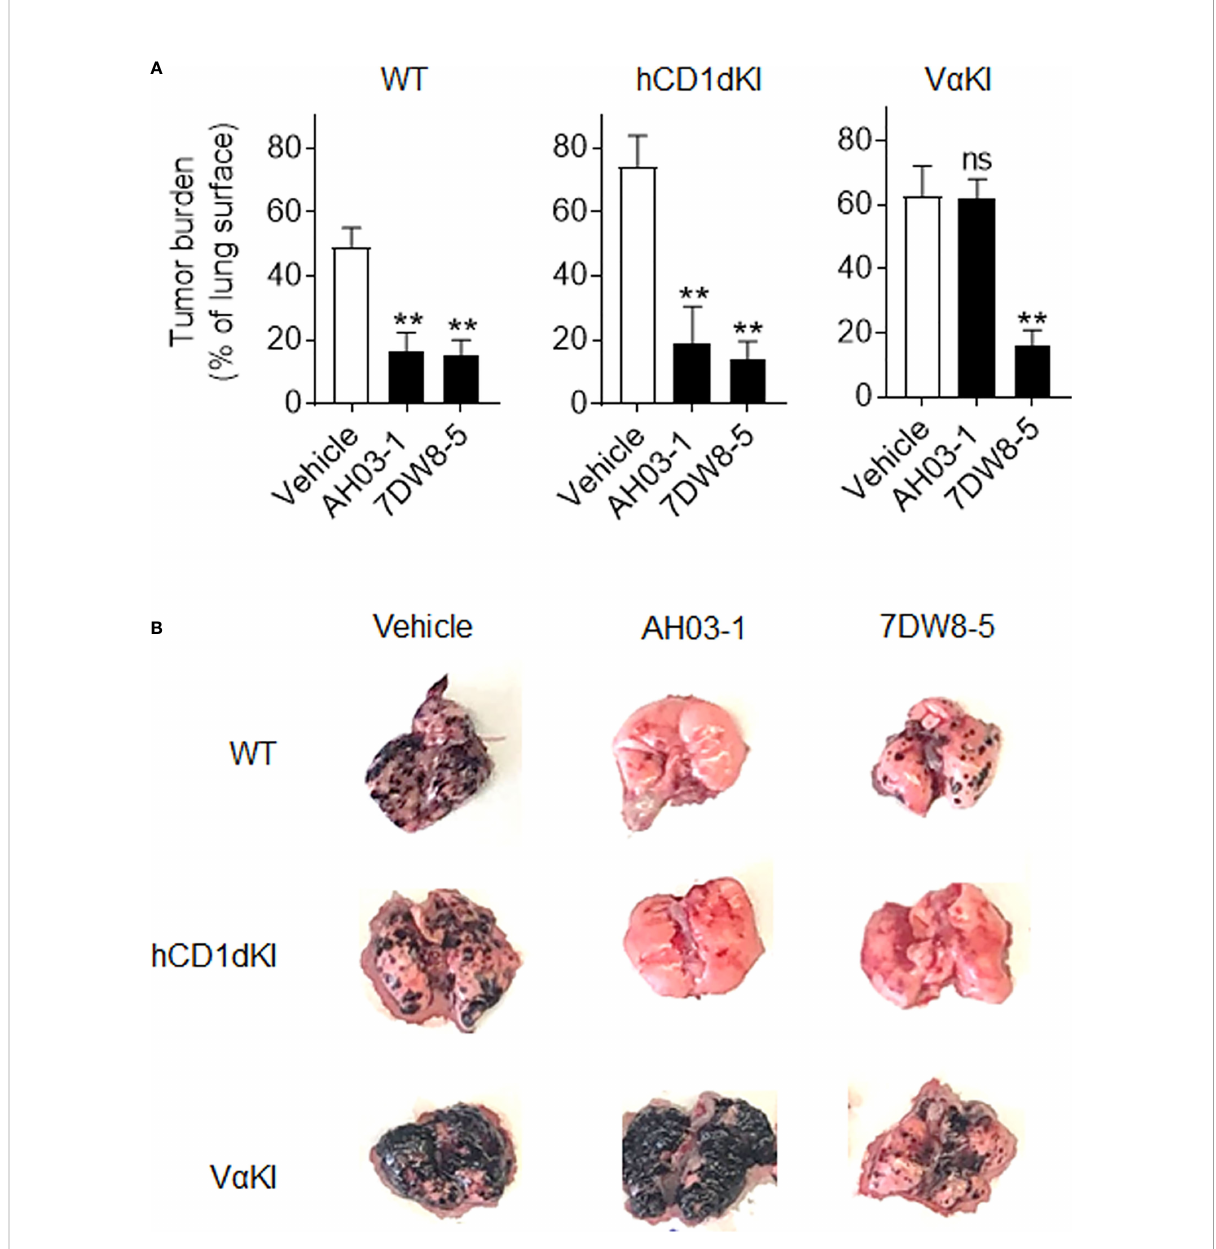
FIGURE 8 Anti-tumor activity and altered glycolipid responses in V a KI mice. (A) Groups of WT (C57BL/6), hCD1dKI or V a KI mice (N = 3 - 5 per group) received intravenous injection of 5 x 10 5 B16-F10 melanoma cells on day 0. Three days later, glycolipids (4 nmol of AH03-1 or 7DW8-5) or inert vehicle were administered as treatment. Animals were sacri fi ced and lungs were extracted on day 15 and digital images obtained for analysis with ImageJ software to determine area of lung surface covered by melanized tumor. Bar graphs show mean percent of involved area ± 1SE. Asterisks indicate signi fi cant differences for glycolipid treated compared to vehicle treated groups. **P < 0.01, ns, not signi fi cant (one-way ANOVA and Tukey post- test for multiple comparisons). (B) Representative images of lungs an individual mouse from each group showing level of gross tumor